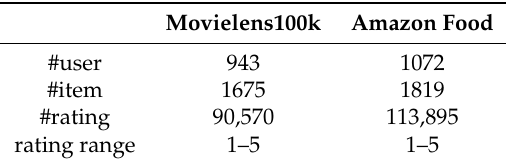
Table 1. Statistics of